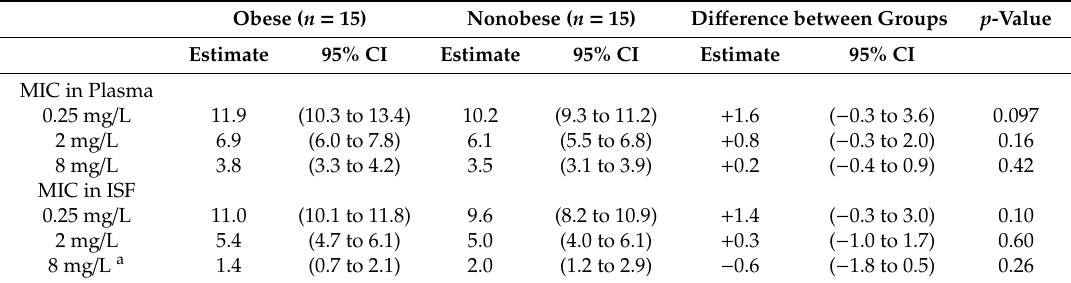
Figure 2. Semilogarithmic concentration–time course (mean and SD) of meropenem in the plasma and interstitial fluid of subcutaneous tissue in obese or nonobese surgical patients following an intravenous infusion of 1 g of meropenem. The dotted line indicates the European Committee on Antimicrobial Susceptibility Testing (EUCAST) breakpoints for Pseudomonas aeruginosa and Enterobacteriaceae. ISF: interstitial fluid. Table 3. Time (in hours) for which the concentration is above the minimum inhibitory concentration (MIC) (T >